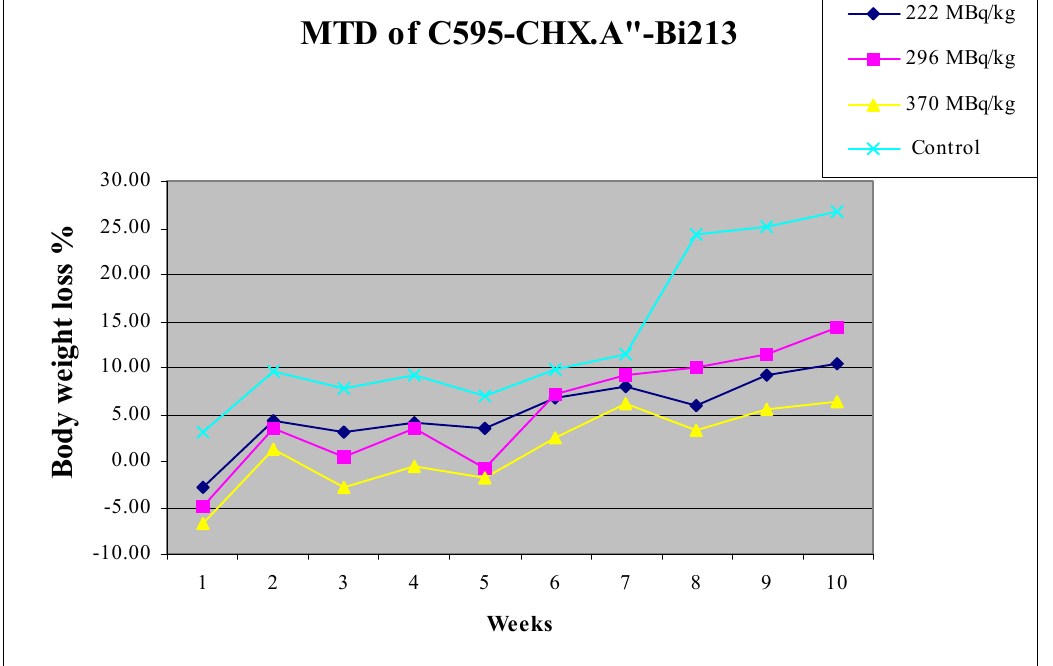
Figure 6. Dose effect of 213 Bi-CHX-A”-C595 on body weight of mice over time [17]. MTD of